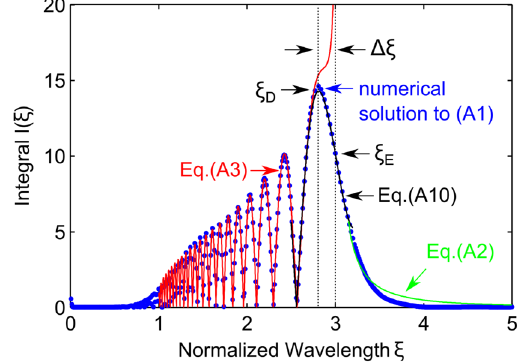
13. Comparison of the analytical solutions (A2), (A3), and (A10) to the numerical integration of Eq.